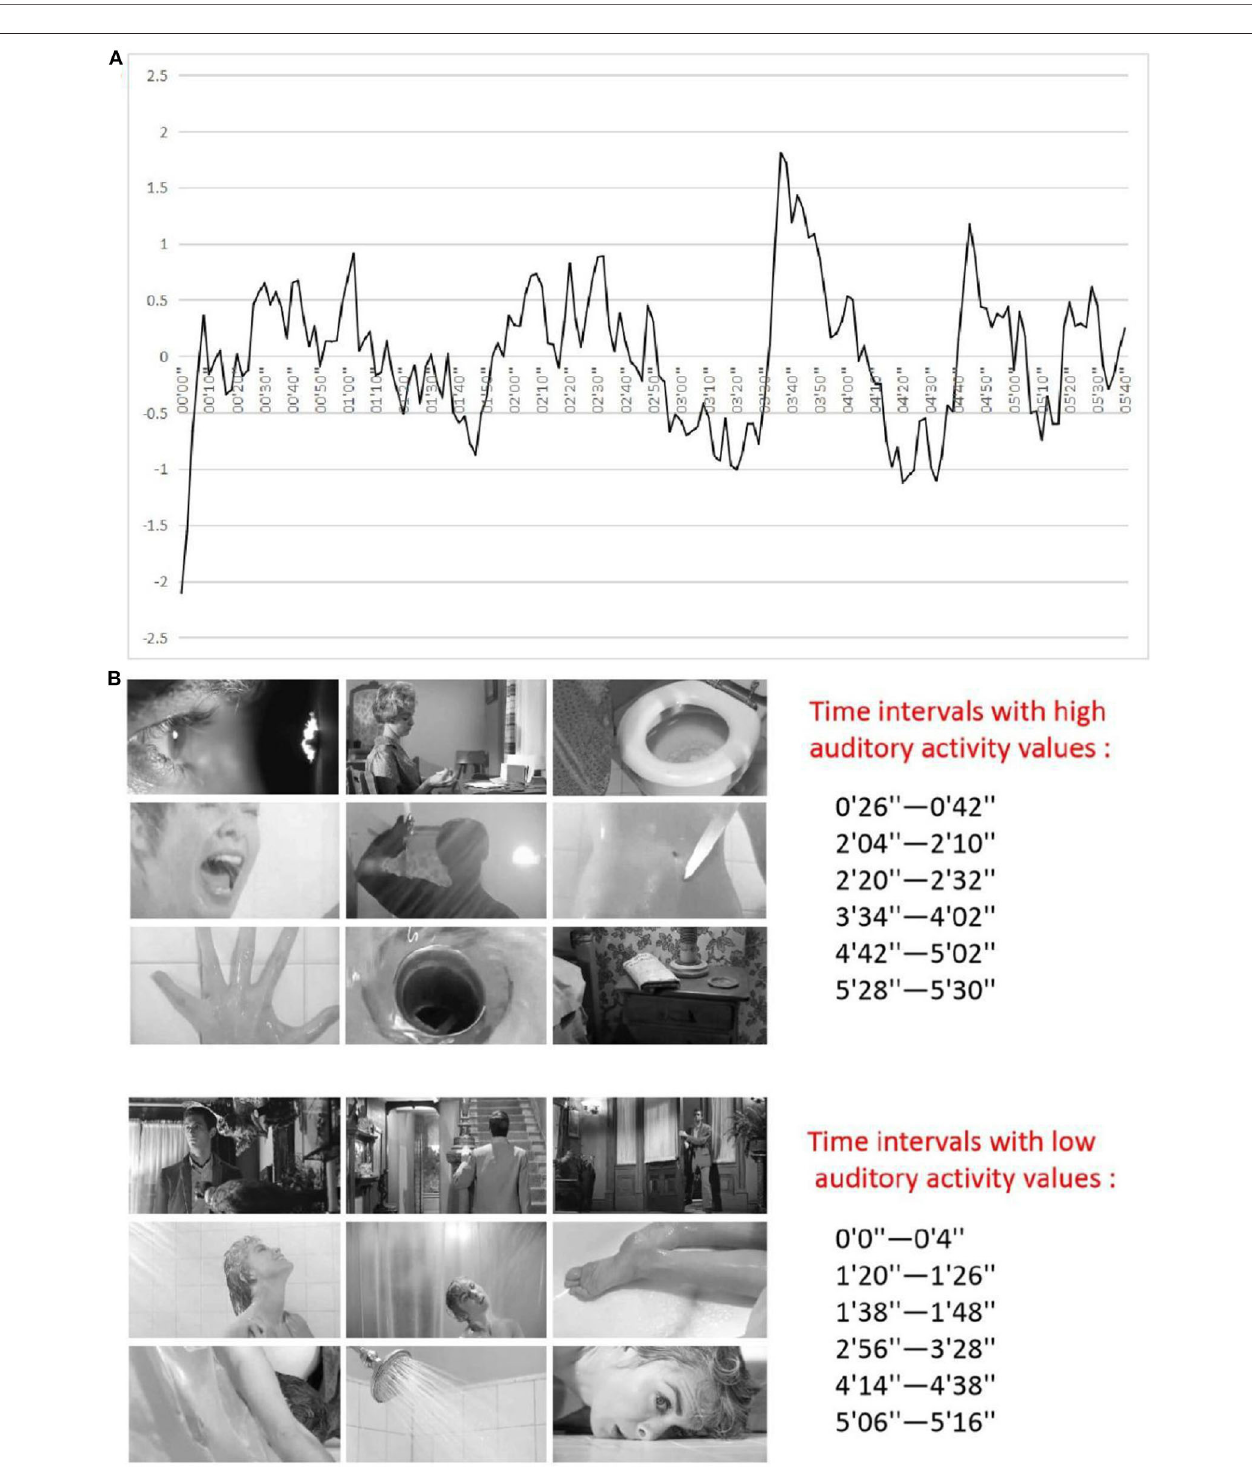
FIGURE 10 | (A) Average activity signals of auditory brain regions over time. (B) Time intervals with high and low auditory activity values and corresponding images.